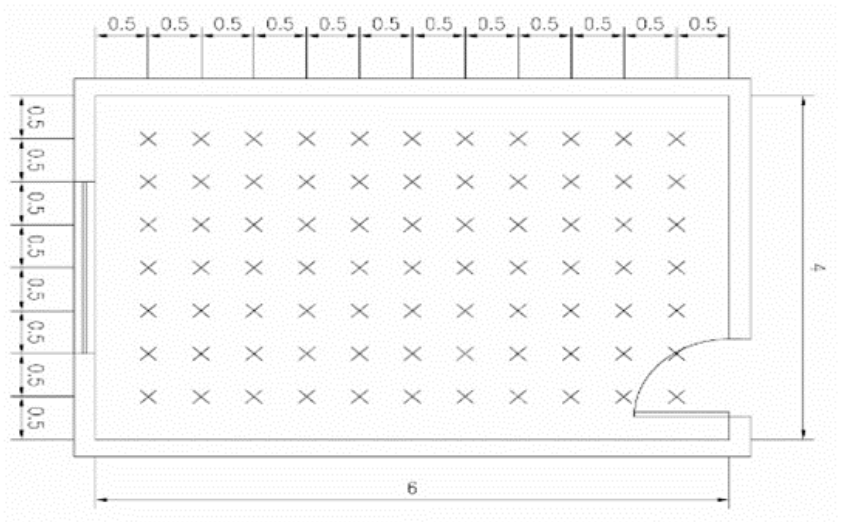
Figure 7. Optical sensors considered in sample office room.